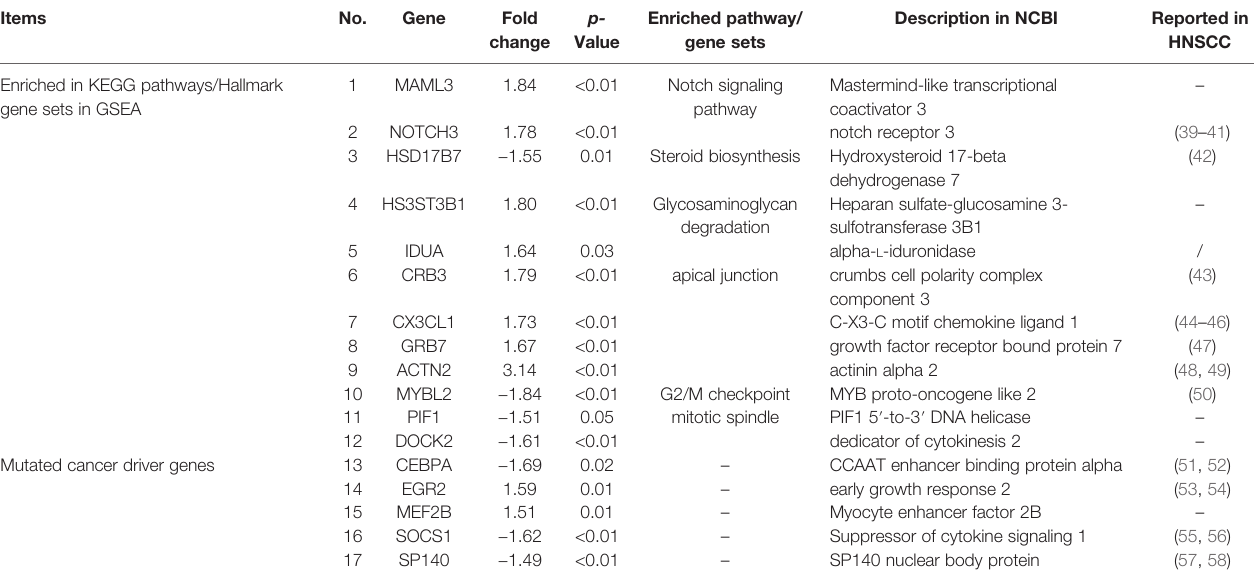
TABLE 3 | Highlighted genes out of 256 differentially expressed genes.